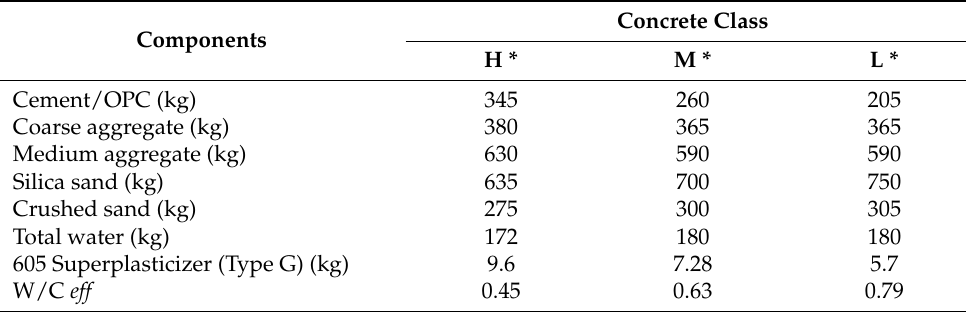
Table 1. Concrete mix